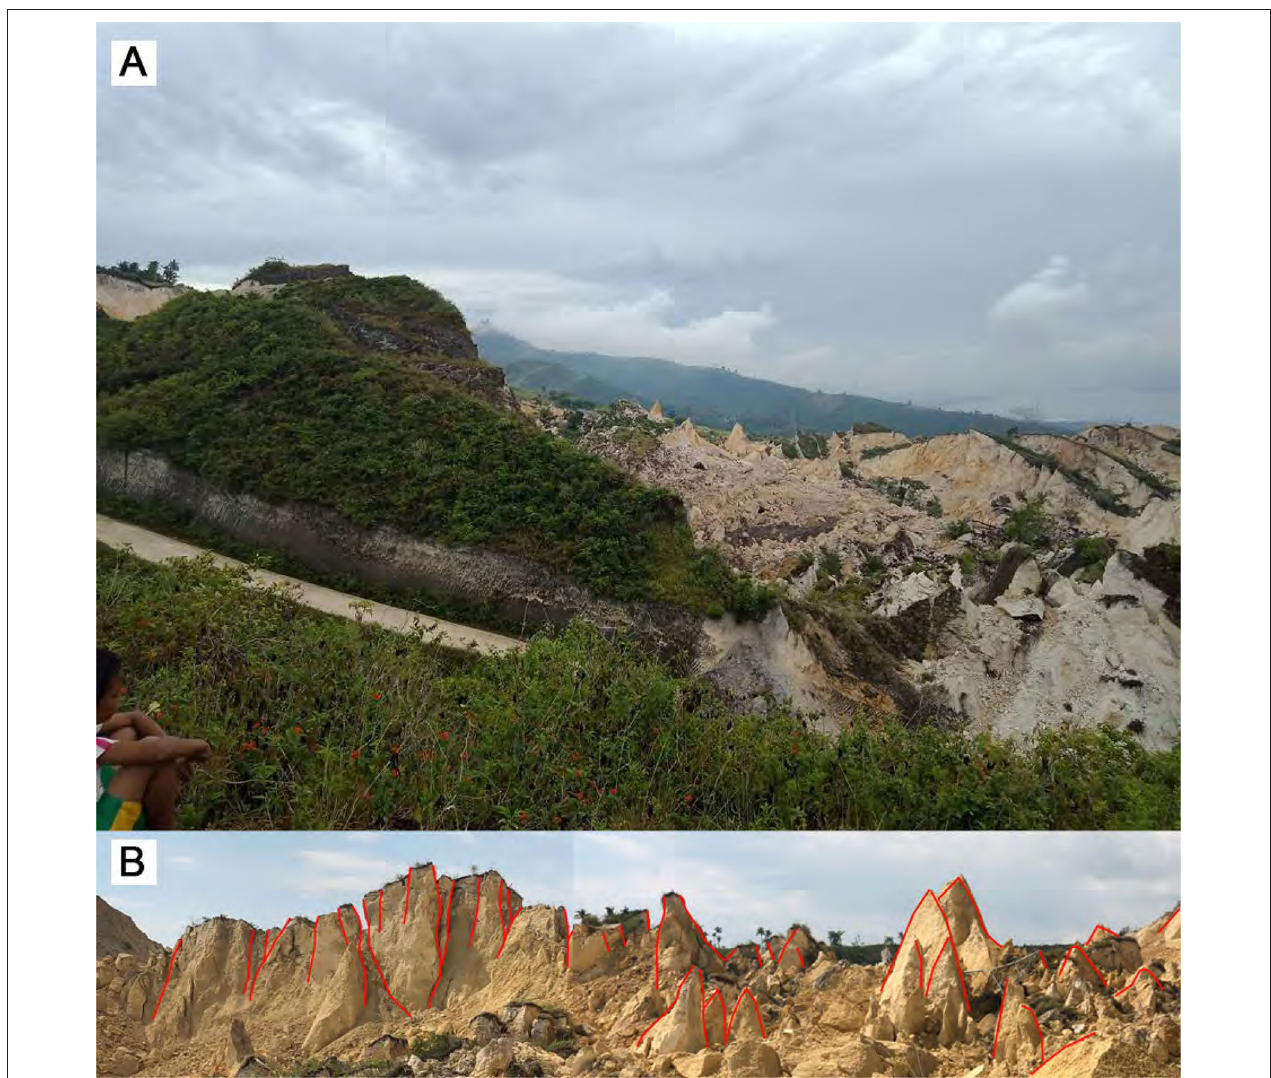
FIGURE 5 | (A) View looking north. Rotated toreva blocks at the proximal portion of the debris field (UP-CENVI, 2018). (B) View looking south-southeast. Horst and Graben structures and pinnacle hummocks formed due to faulting as the slide was